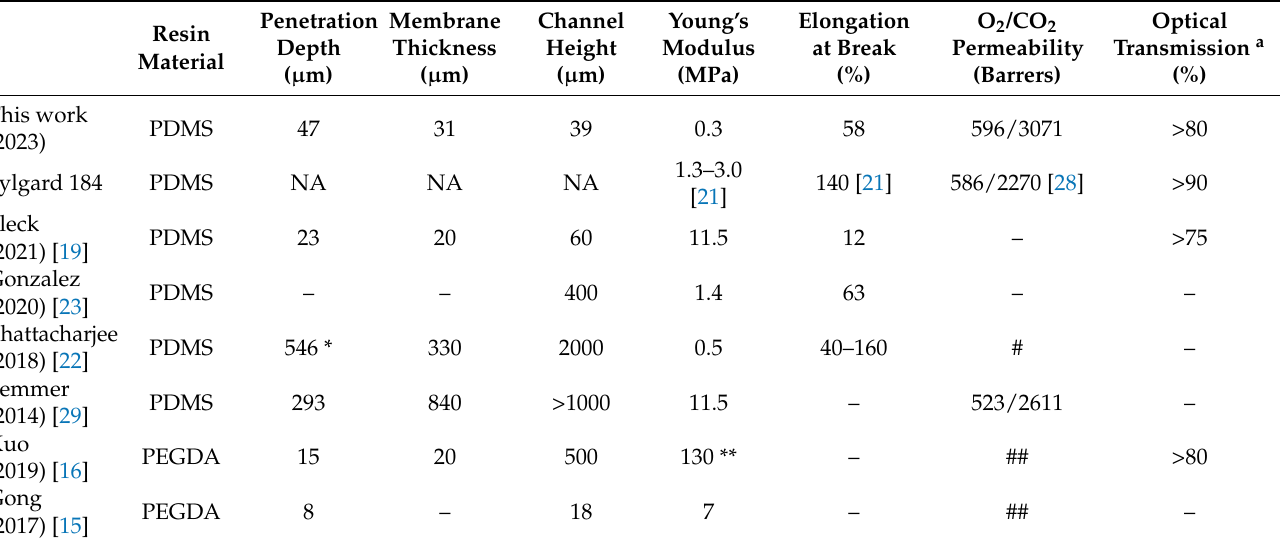
Table 2. Comparison of print resolution and material properties of DLP 3D-printing resins with Sylgard